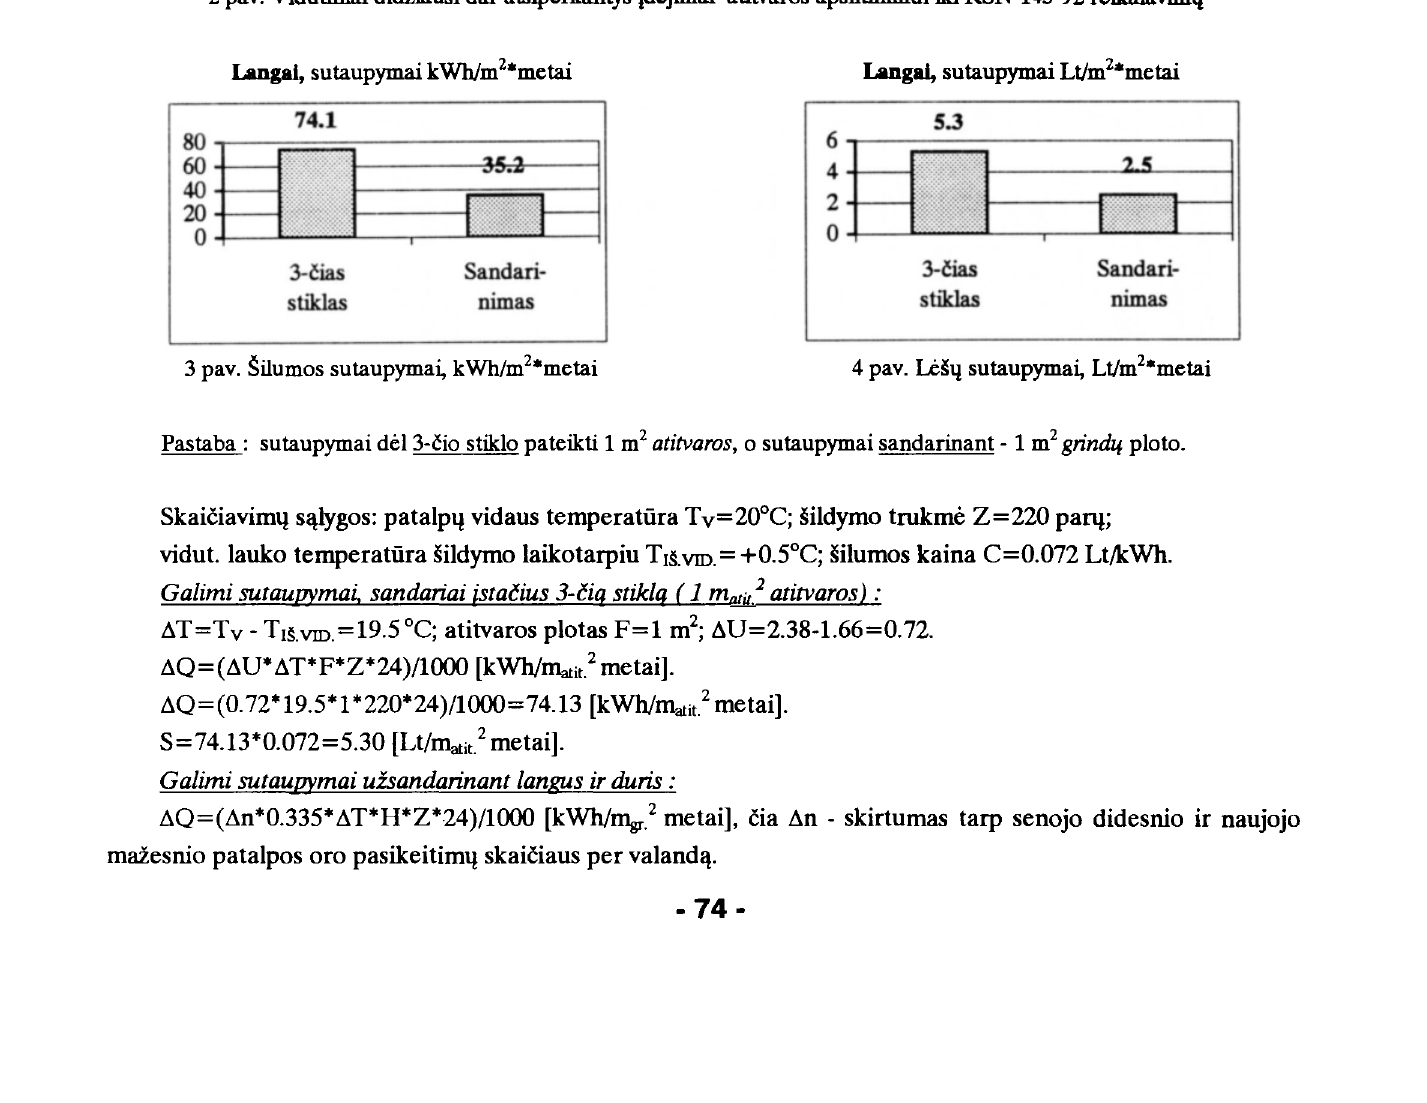
Pastaba:- iSlaidos skaiciuotos esant Tv=20°C; Z=220 parq; T 1 s.vm.= +O.SOC; - iSlaidos vedinimo ~ilumogrllfai pateiktos 1m 2 grindu; tai gali buti ir ~ilumos nuostoliq del vedinimo+infiltracijos sumaZinimas pusiau, sandarinant Iangus ir duris; - ekonomines skaiciavimo satvgos: - dabartine ~ilumos kaina C=0.072 Lt/kWh; - 10 metq paskola: grynas pelnas(palUkanos) p=10%/metai; santykinis(grynas) ~ilumos brangimas e=5.4%/metai - 10 metq lengyatine paskola: vidutine infliacija per 10 metq imta i= 15%/metai; vardines /engvatines banko paiUkanos pn=l3%/metai; santykinis(grynas) silumos brangimas e=5.4%/metai 2 pav. Vidutiniai did.Ziausi dar atsiperkantys idejimai atitvaros ap~iltinimui iki RSN-143-92 reikalavimq Langal, sutaupymai kWh/m 2 *metai Langai, sutaupymai Lt/m 2 *metai